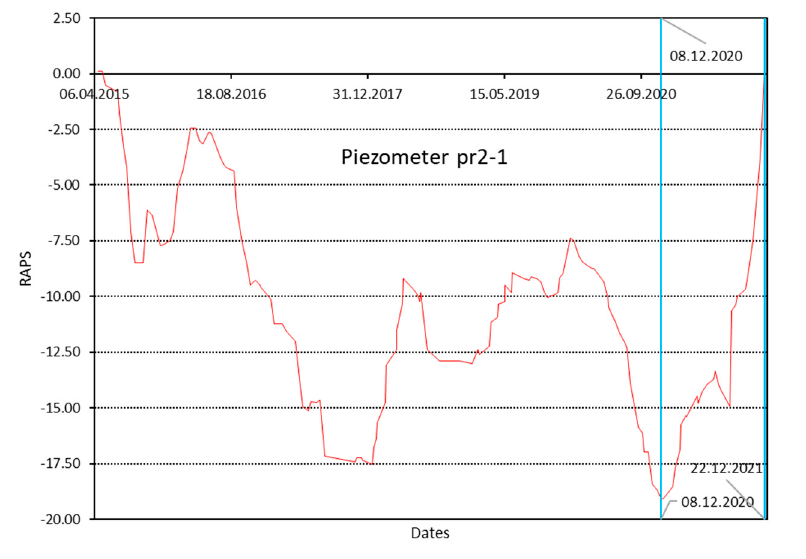
Figure 15. RAPS values for piezometer PR3/4.